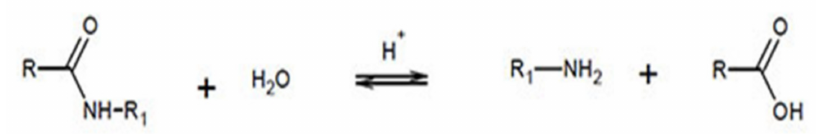
Figure 18. Reversible reaction of an amide in an acid medium in